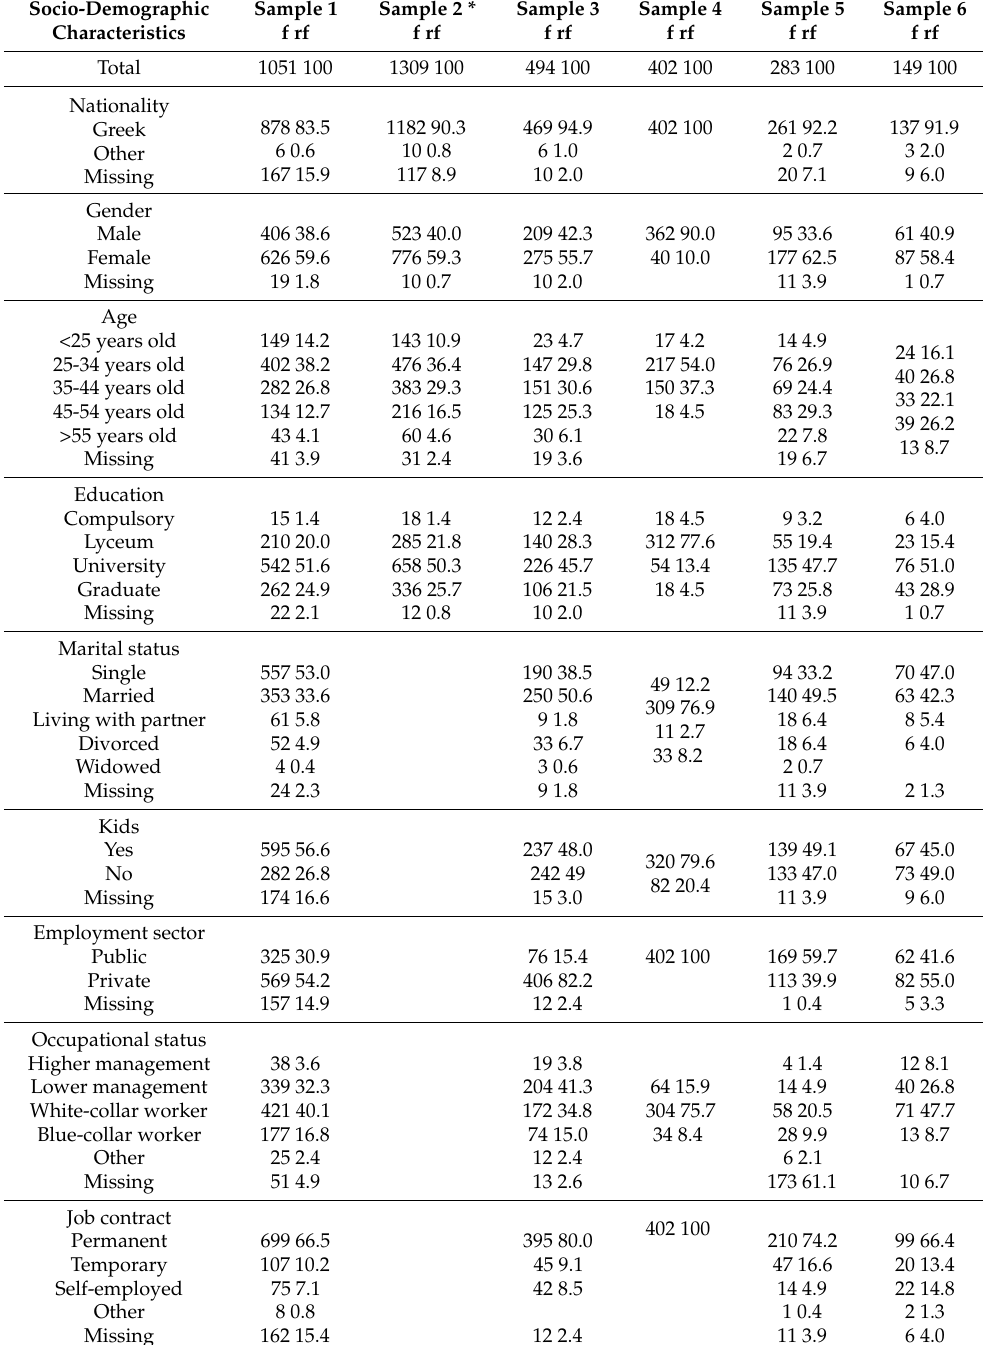
Table 1. Composition of Samples 1, 2, 3, 4, 5, and 6 according to sociodemographic